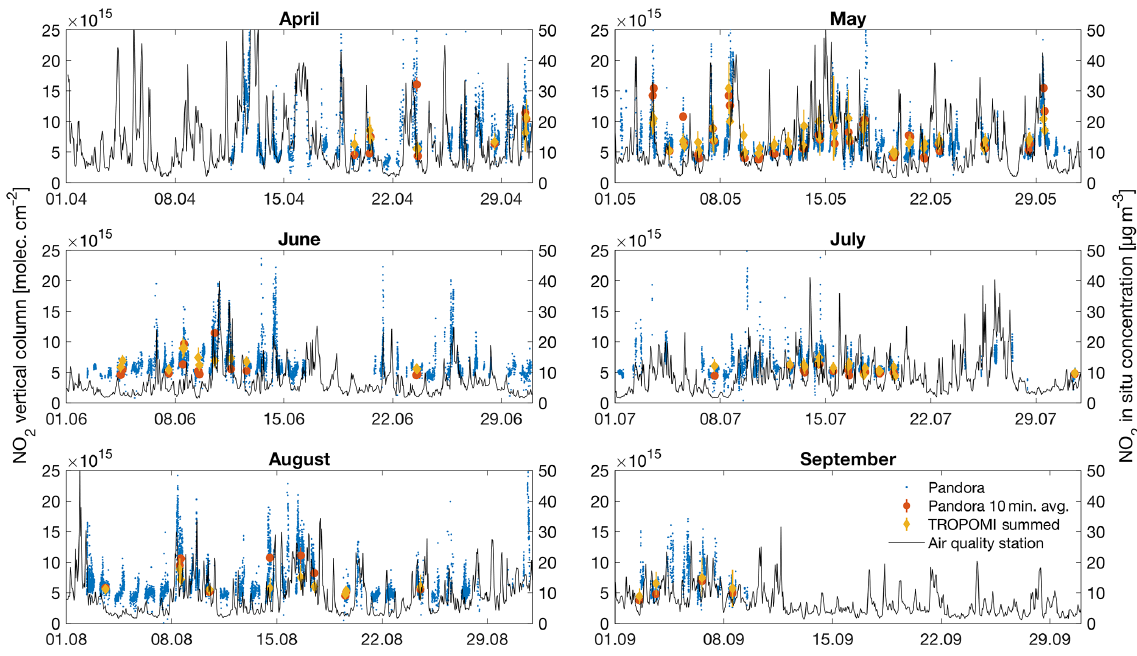
Figure 2. Time series of collocated Pandora total and TROPOMI summed NO 2 columns during the period 15 April to 30 September 2018. Blue dots are all the available Pandora observations; red dots are the Pandora observations averaged 10min before and after S5P’s overpass (with standard errors of the mean as error bars); yellow diamonds are TROPOMI summed columns of the pixels including the ground-based Pandora station (with retrieval precisions as error bars). The black line (right y axis) indicates the NO 2 surface concentrations from the in situ measurements at the Kumpula AQ station. Table 1. Statistics of the comparison between TROPOMI and Pandora NO 2 total columns. The uncertainties are the corresponding standard errors of the mean. The uncertainty estimates used in the York fit are pixel-specific precisions for TROPOMI (included in the data product), and standard errors of the mean for Pandora as calculated for the set of measurements within 10min of the S5P overpass. n g MRD a MD b σ c r d slope e slope f Y LS All